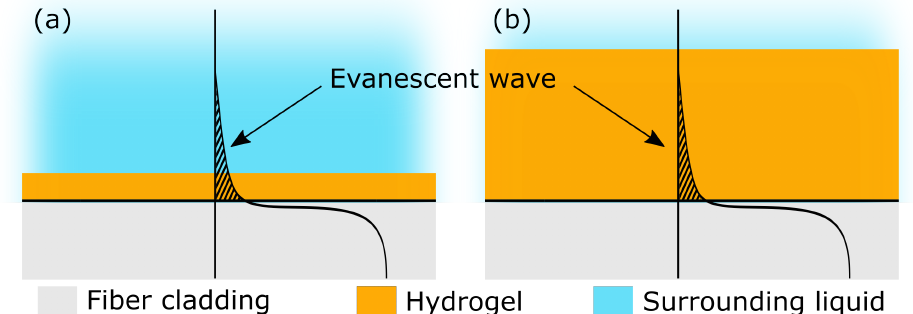
Figure 9. Schematic picture showing the interaction of the evanescent wave with the hydrogel coated layer on the fiber cladding. For thin hydrogel layers, the evanescent wave will be influenced not only by the RI of the hydrogel but also the RI of the surrounding liquid ( a ). For thicker layers the evanescent wave will only be influenced by the effective index of the hydrogel ( b